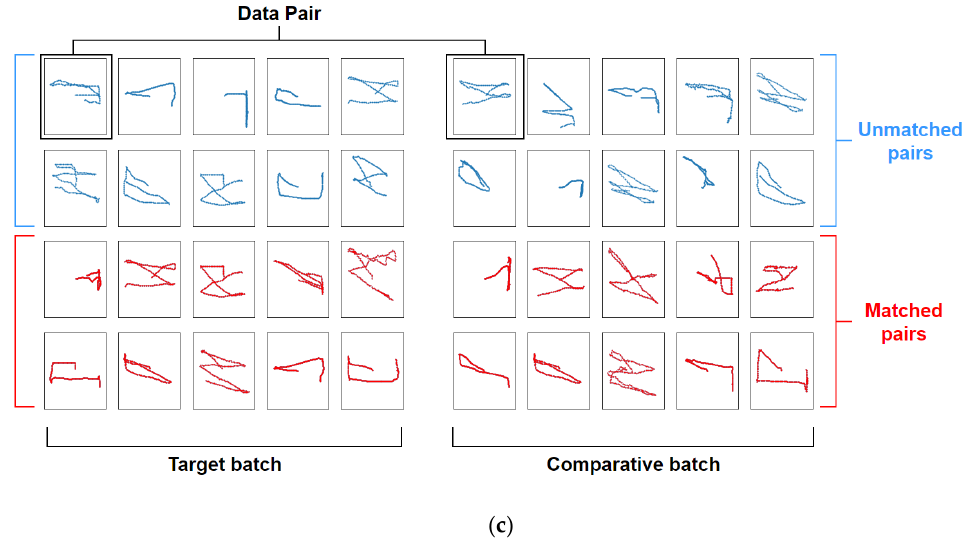
Figure 9. Data batch pairs for training with different conditions for comparative batch. ( a ) Reference data only, ( b ) eye-written characters for unmatched pairs, and reference data for the matched pairs, ( c ) eye-written characters